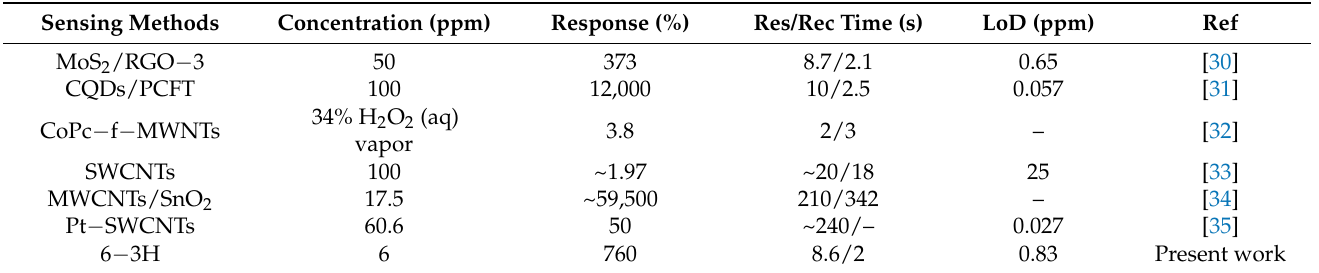
Table 1. Sensing performance of the recently reported H 2 O 2 gas sensors.